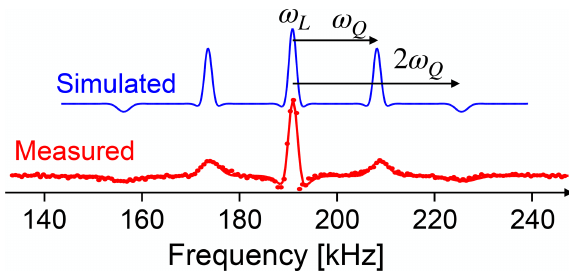
Figure 25. Spectrum of 75 As obtained by Fourier transformation of the FID signal measured via the Hanle effect after pulsed